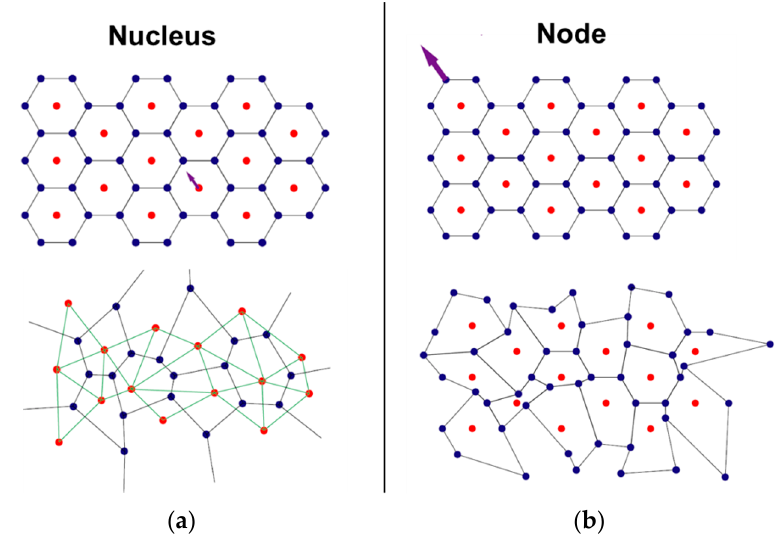
Figure 12. Two approaches to applying perturbation, at the level of ( a ) the nucleus and ( b ) the node, as indicated by the arrows. as indicated by the